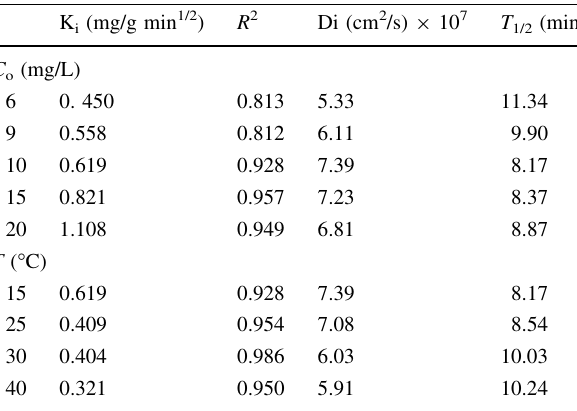
Fig. 10 Pseudo-second biosorption kinetics of pre-treated